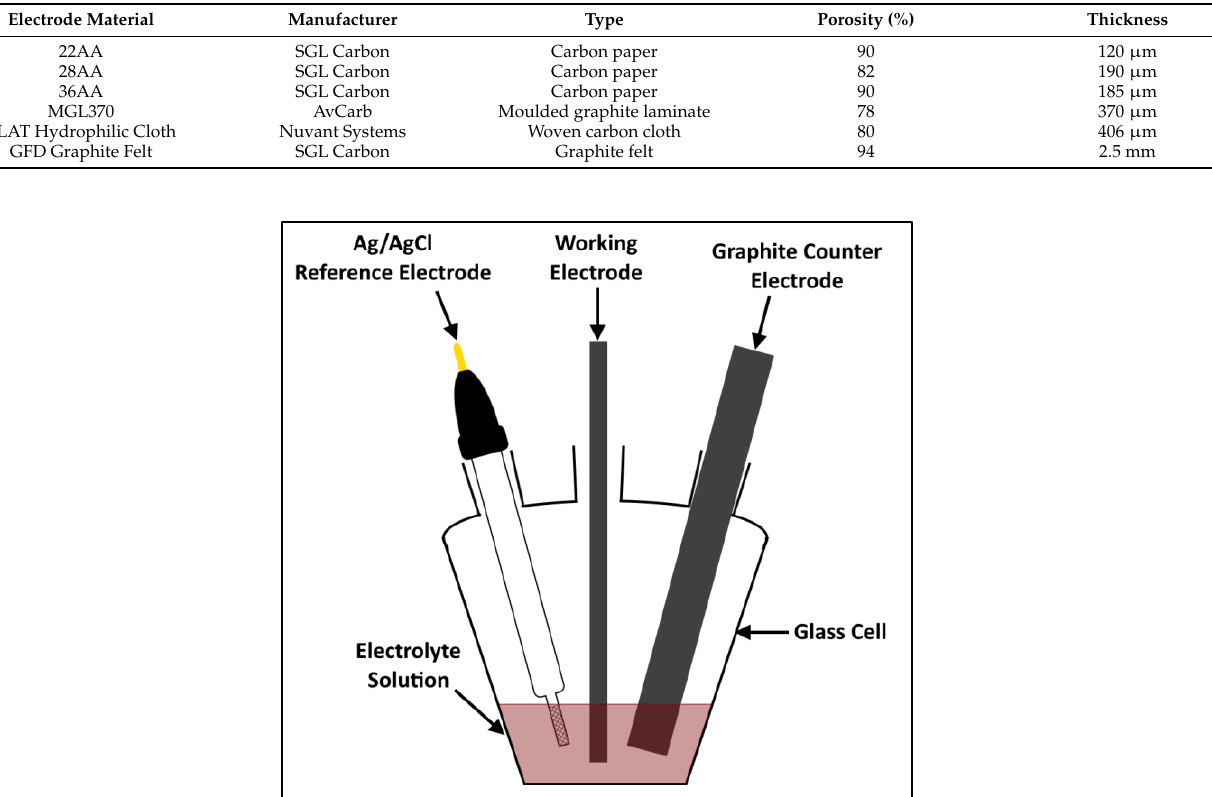
Table 1. Electrode materials under investigation.